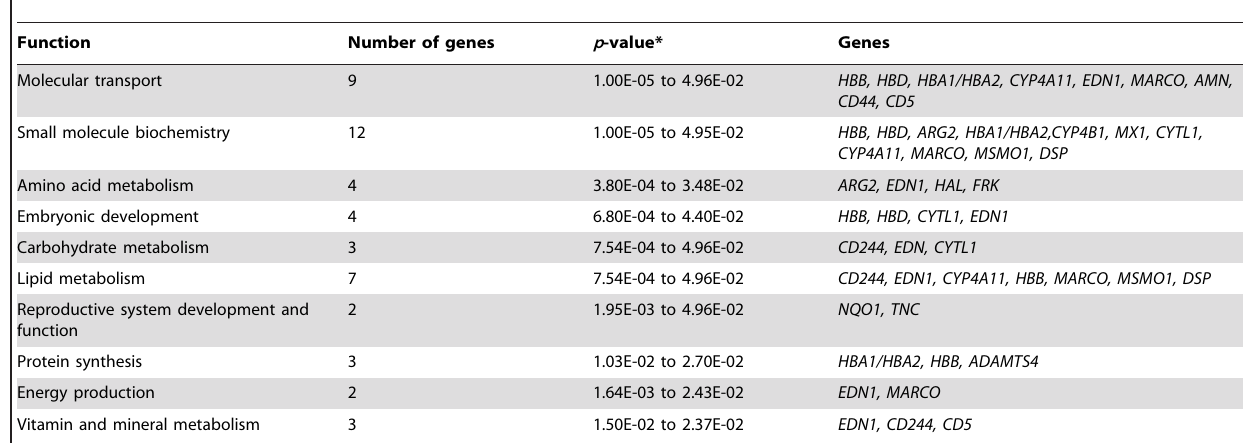
Table 5. Functional categories and corresponding DEGs in high androstenone testis tissues.